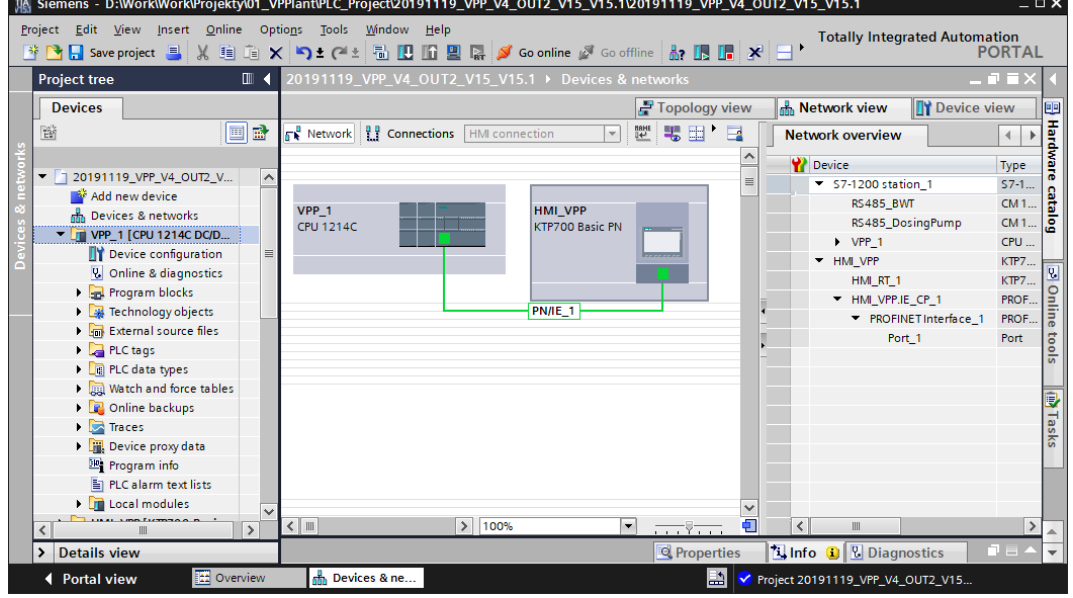
Figure 8. General view of control project in TIA Portal.